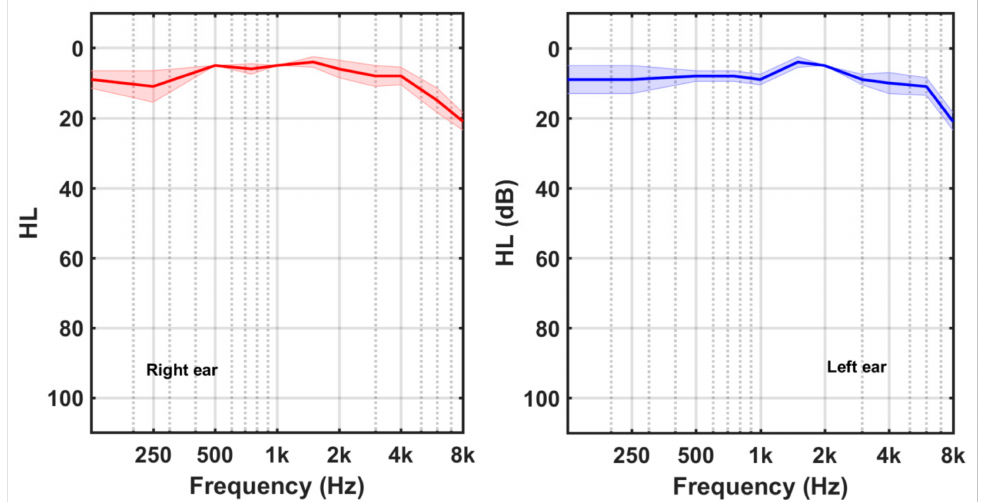
Figure 2. Average HL curves of the participants with normal hearing (NH).